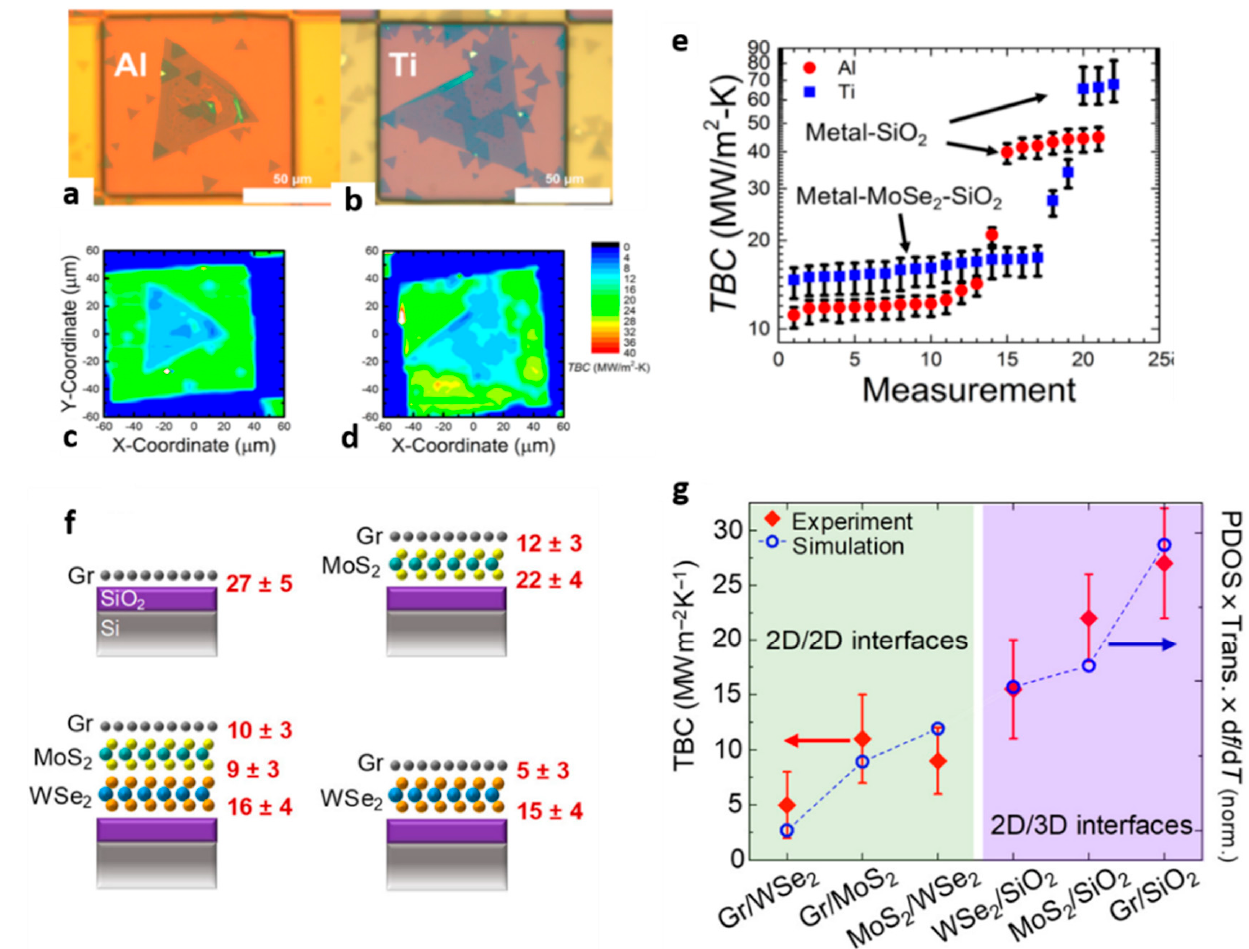
Figure 6. Phonon engineering in TMDC-based interfaces. Optical images showing the probed region of ( a ) Al–MoSe 2 –SiO 2 and ( b ) Ti–MoSe 2 –SiO 2 interfaces. ( c , d ) thermal boundary conductance (TBC) maps of the Al and Ti covered regions of the sample obtained by using time-domain thermoreflectance method (TDTR). ( e ) TBC values obtained at several positions across MoSe 2 islands. ( f ) Schematics of TBCs measured across heterostructures consisting of graphene (Gr), Gr/ MoS 2 , Gr/WSe 2 , and Gr/MoS 2 /WSe 2 . ( g ) Measured TBC values of 2D/2D and 2D/3D (with SiO 2 ) interfaces (red diamonds, left axis) and calculated values (open blue circles, right axis). The TBC were obtained by using single Laser Raman thermometry technique. ( a – e ) Reproduced with permission from [103]. Copyright American Chemical Society, 2019. ( f , g ) Reproduced with permission from [105]. Copyright American Institute of Physics, 2014.